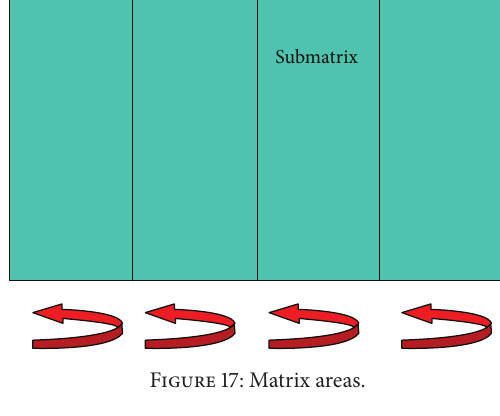
Figure 17: Matrix areas.